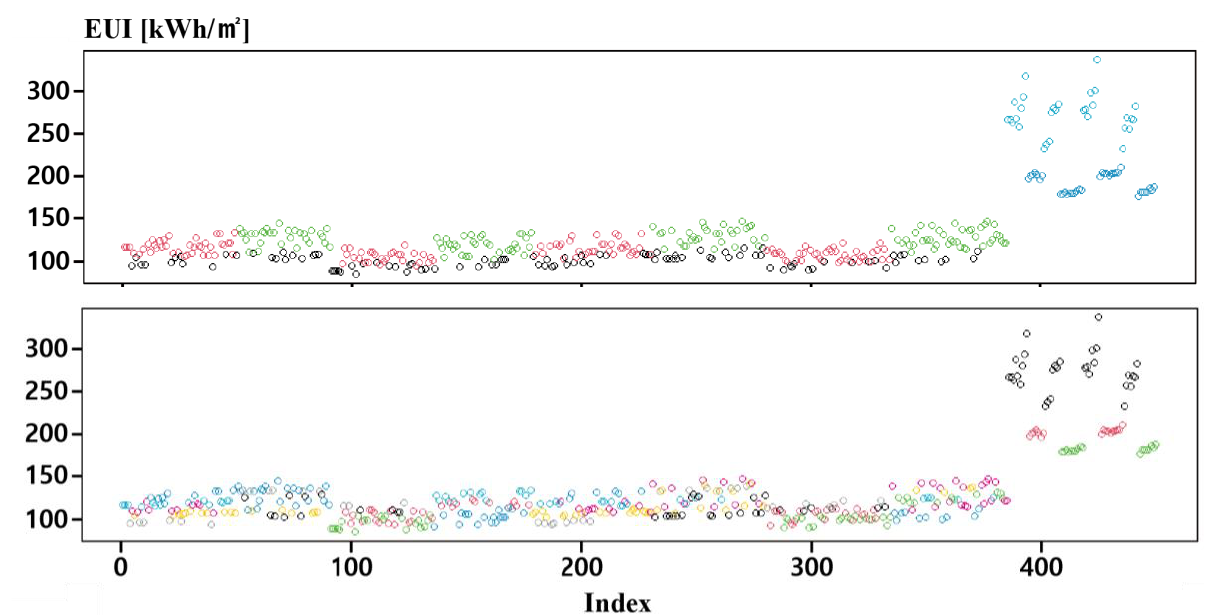
Figure 5. CART clusters ( top ) and CIT clusters ( bottom ).